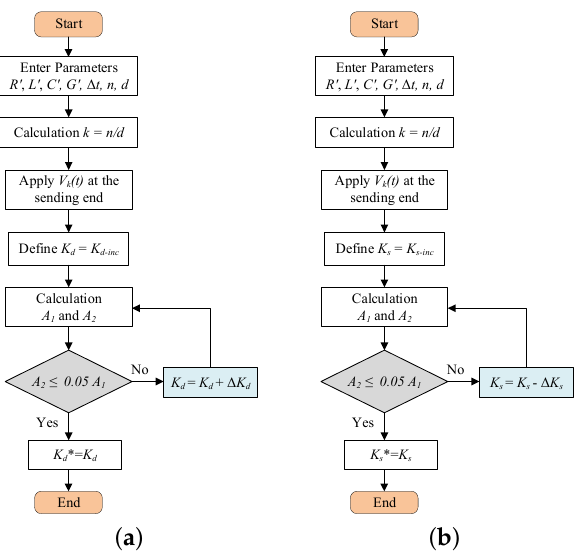
Figure 4. Flow-chart to obtain the optimum adjustable factors: ( a ) K ∗